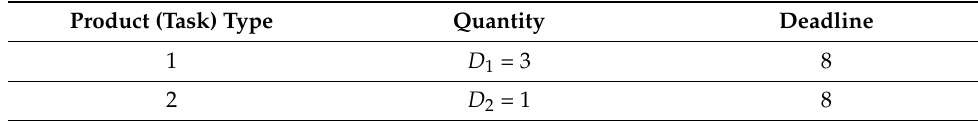
Table 3. Requirements of an order.